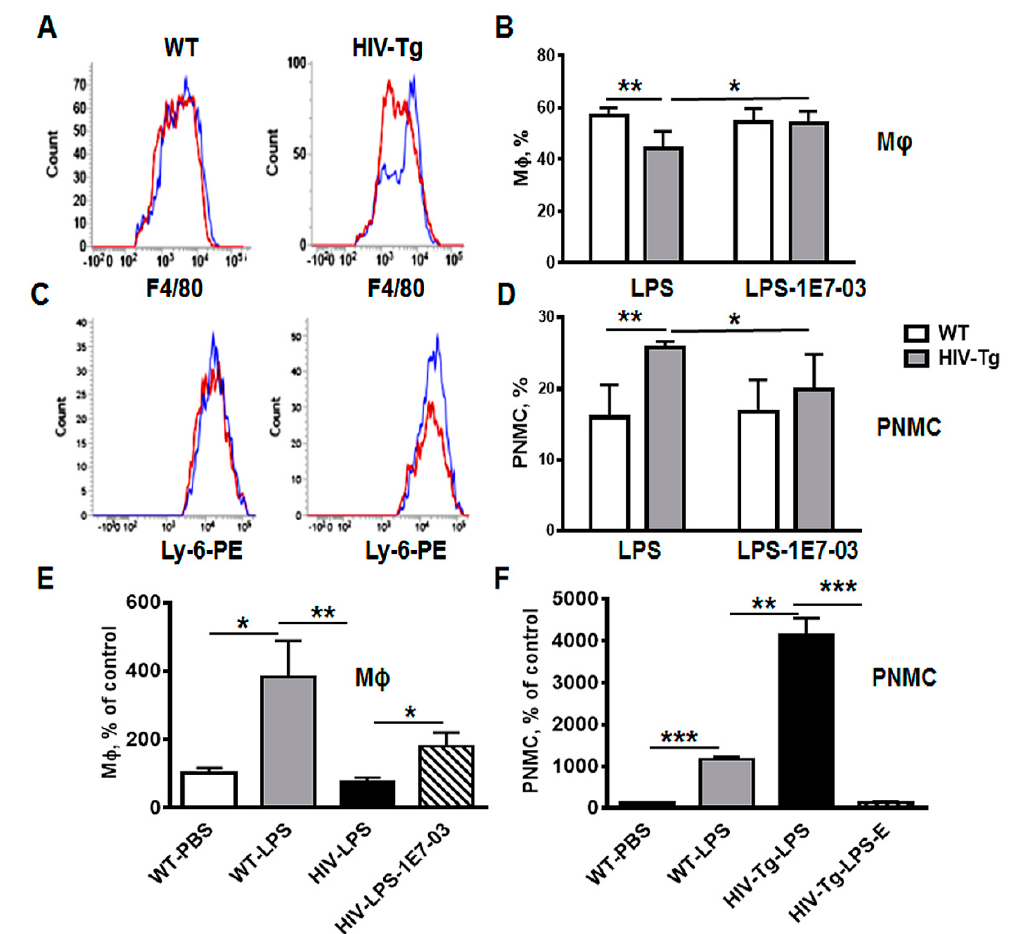
Figure 7. Administration of HIV-1 transcription inhibitor decreases neutrophil levels and increases macrophage levels in HIV-Tg mice injected with LPS. ( A , B ) Representative flow cytometry analysis of lung macrophages (A, F4/80-FITC) and neutrophils (B, Ly-6-PE) in WT and HIV-Tg mice at 48 h after LPS administration. Blue color indicates vehicle, red color—1E7-03 (HIV-1 transcriptional inhibitor). ( C , D ) Percent of lung macrophages (C) and neutrophils (PNMC, D) quantified by flow cytometry. Three mice were used for each treatment. Flow cytometry samples were run in duplicate. Asterisks indicate: * p < 0.05, ** p < 0.01, *** p < 0.005.